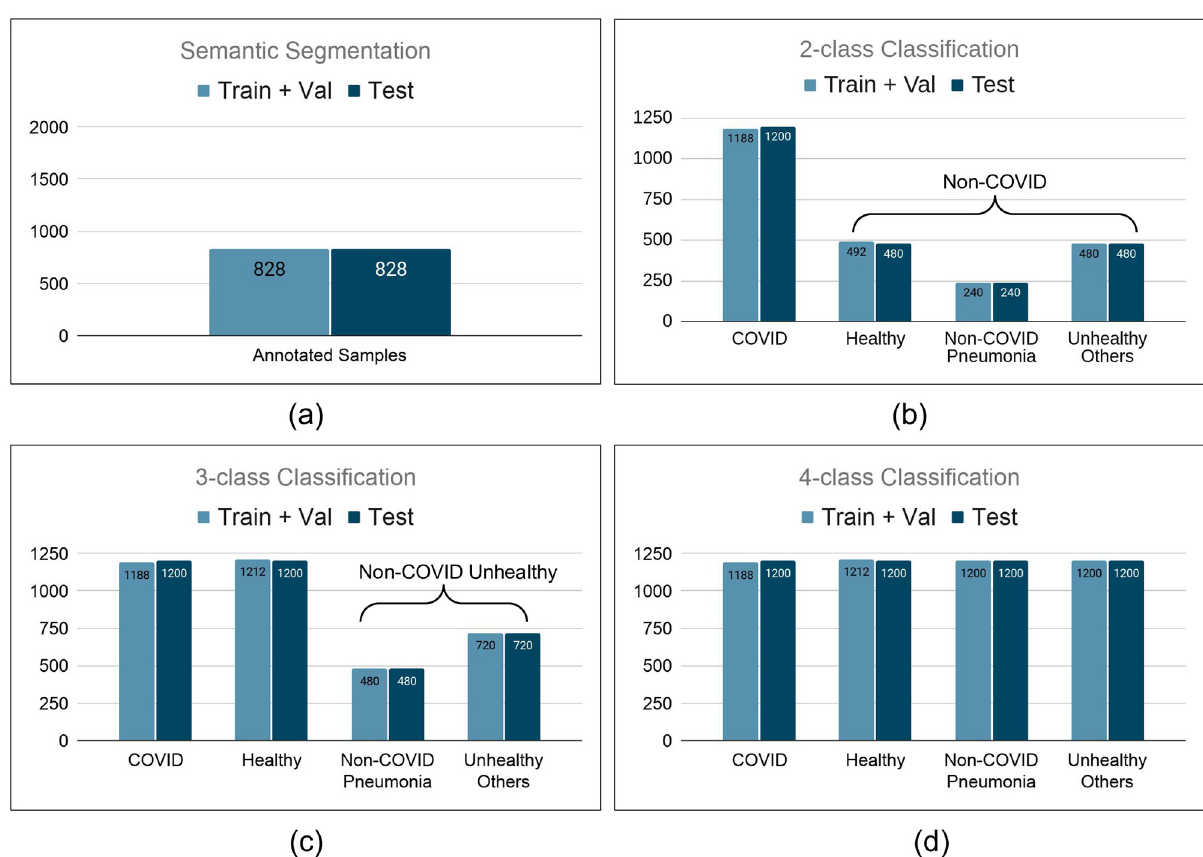
Fig 4. Number of samples present in protocol for (a) Semantic Segmentation. (b) 2-class Classification. (c) 3-class Classification. (d) 4-class Classification.